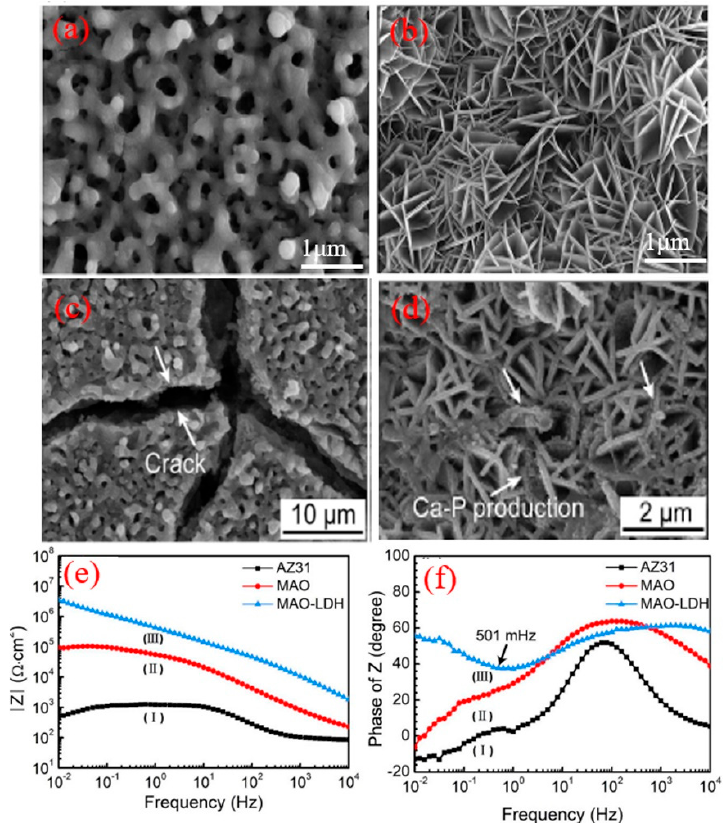
Figure 6. SEM images of the plasma electrolytic oxidation (PEO) coating and PEO–LDH composite coating before and after immersion for 154 h in 3.5 wt.% NaCl solution where ( a – c ) PEO coating and ( b , d ) PEO–LDH coating. ( e , f ) represents the Bode plots of AZ31 Mg alloy substrate, PEO coating, and PEO–LDH coating, respectively [89].